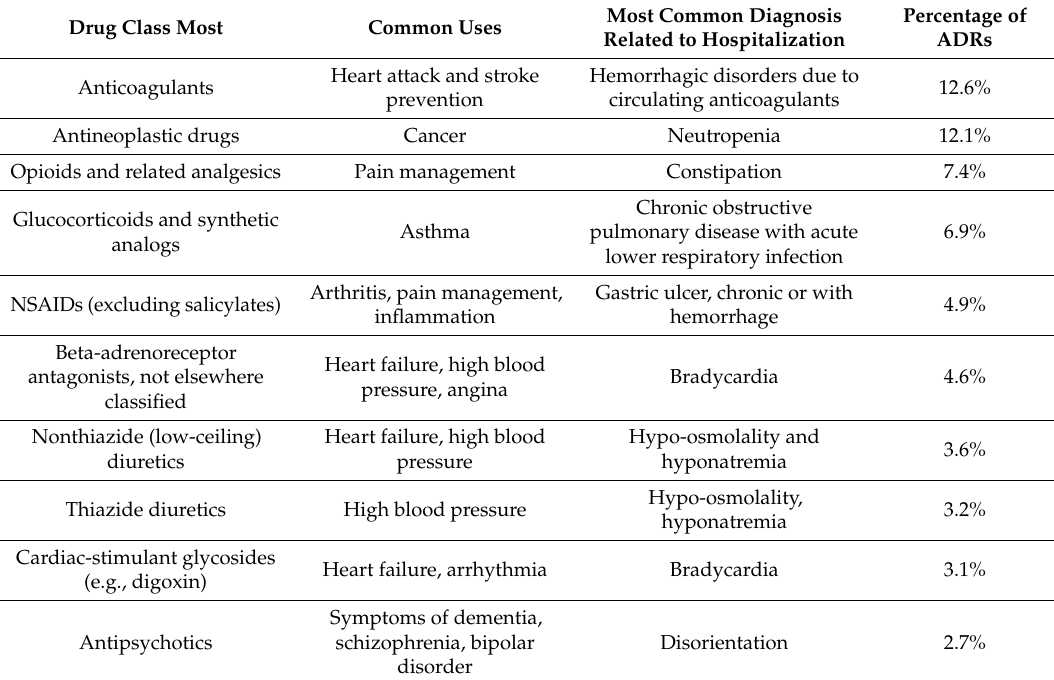
Table 3. Top 10 drug classes most commonly associated with seniors’ Adverse Drug